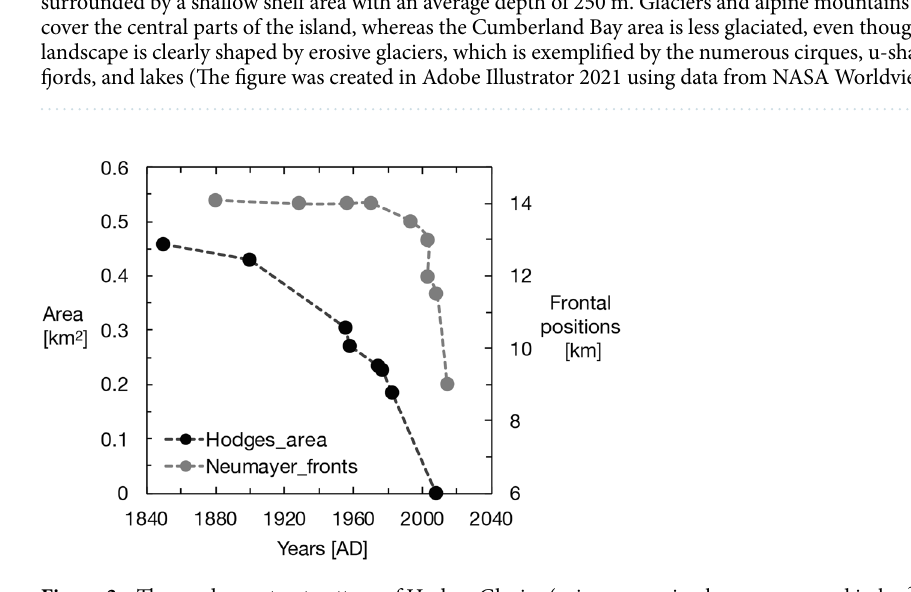
several minor readvances superimposed on a sustained gradual retraction, which has culminated in accelerated retreat and thinning after AD 1950 (Figs. 3 and 4).